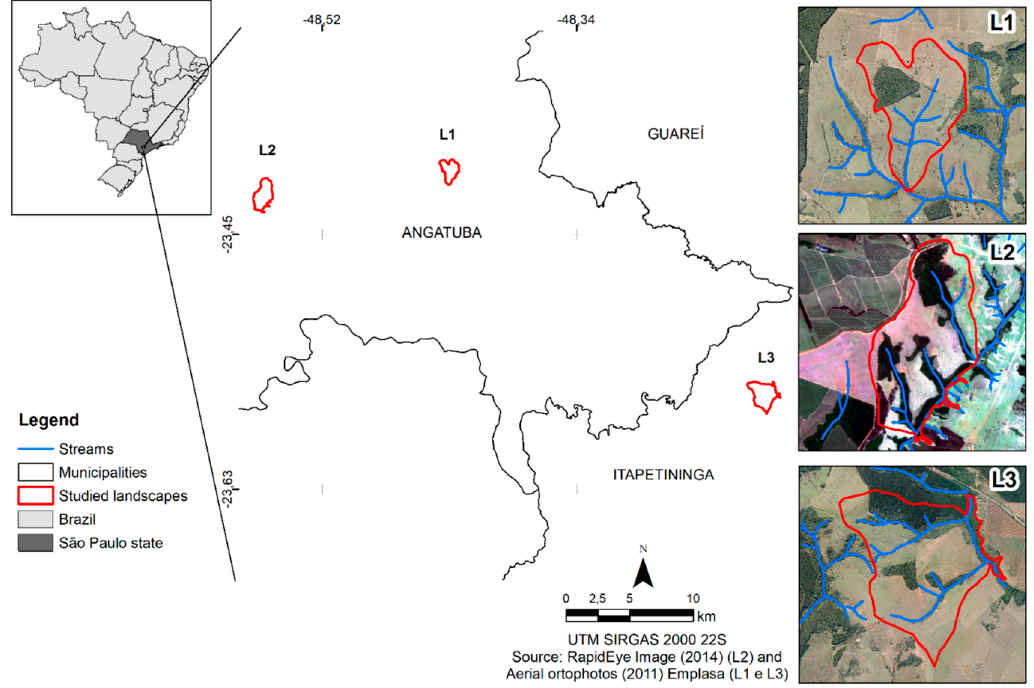
Figure 1. Landscapes with pasture matrix evaluated (L1, L2, and L3) in the Cerrado region in southwestern São Paulo.